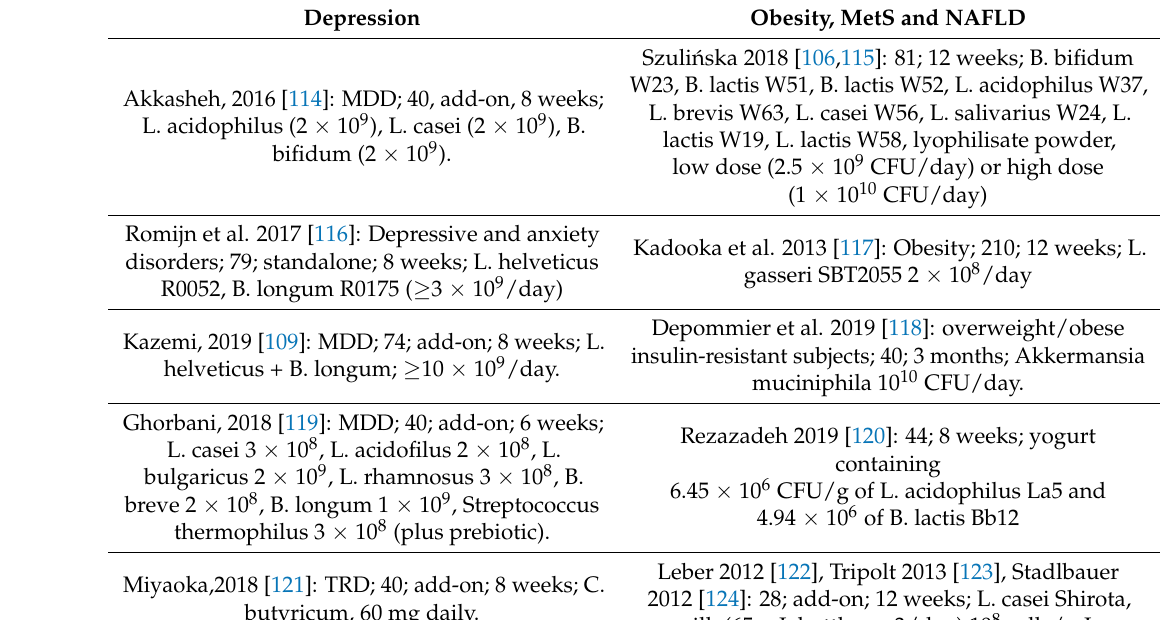
Table 3. The selected recent randomized clinical trials with probiotics formulations in the field of depressive and metabolic